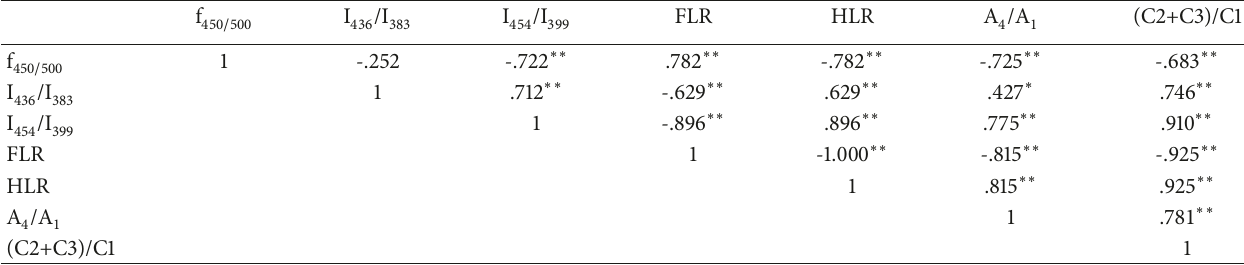
Table 1: Correlation matrix between parameters of different fluorescence characteristics.